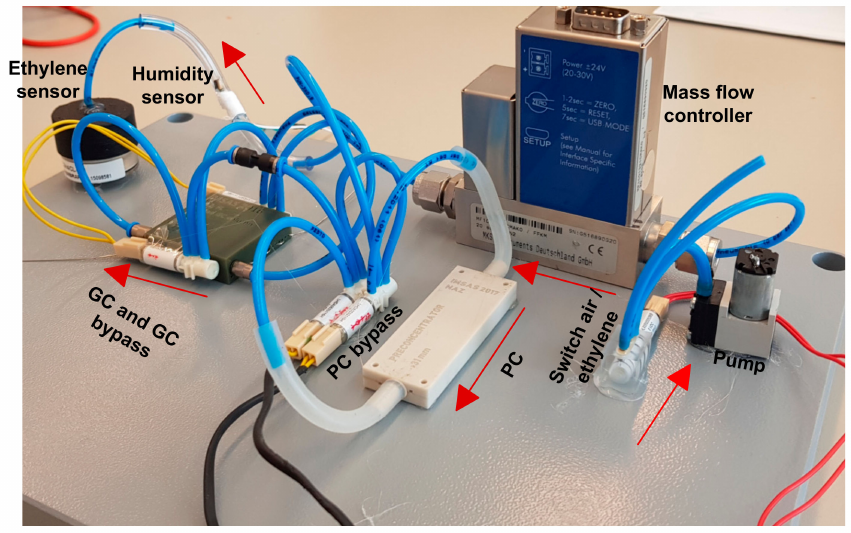
Figure 7. Gas chromatographic